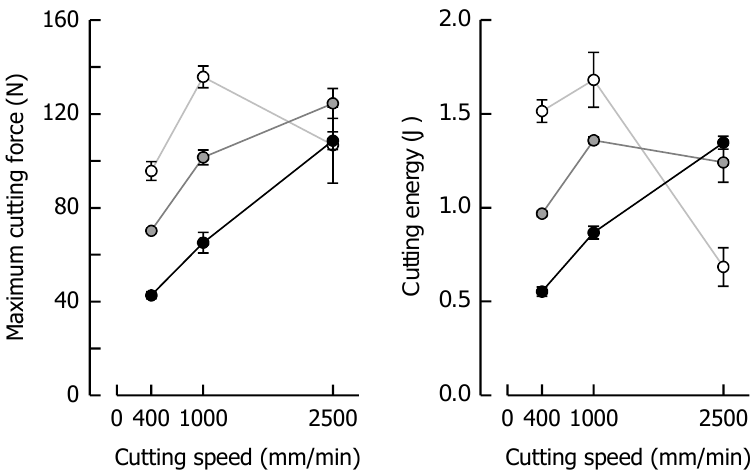
Figure 4. Relationships between maximum cutting force and cutting speed ( left ) and cutting energy and cutting speed ( right ) for caramels with 9.64% (black), 8.57% (grey), and 7.98% (white) moisture content. Data are arithmetic means ± standard deviation for maximum cutting force or cutting energy ( n = 4) and for moisture ( n = 3).